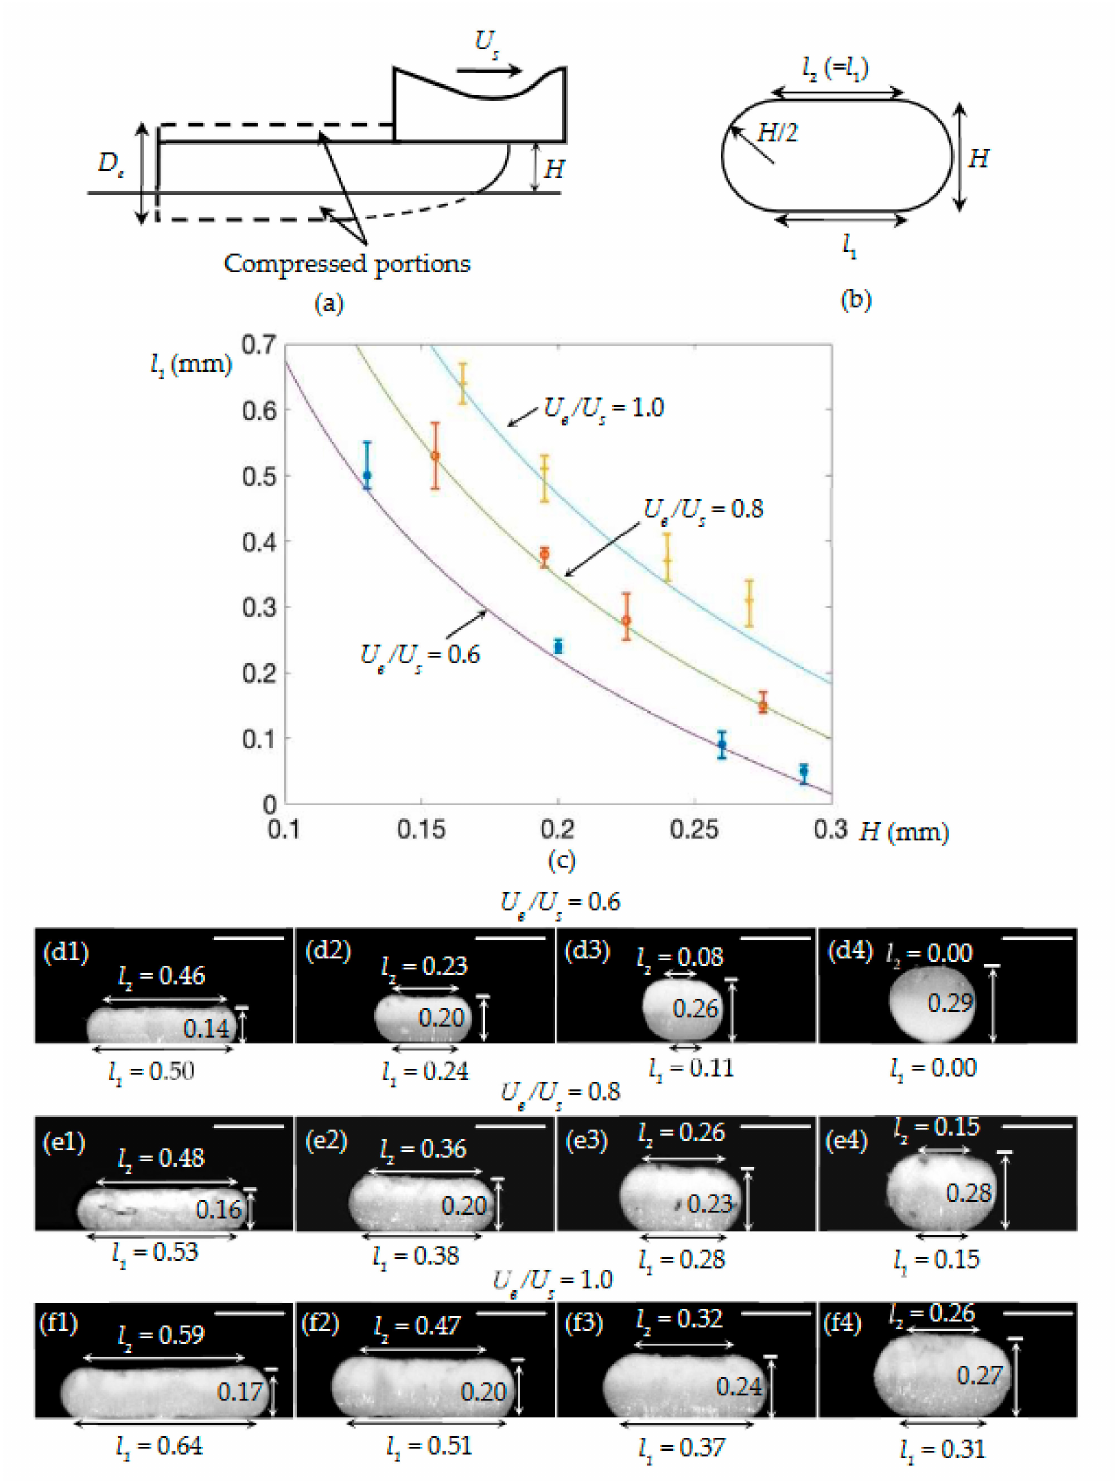
Figure 4. ( a ) Illustration of Case I.2. ( b ) Predicted cross-section of a deposited strand. ( c ) Theoretical and experimental H - l 1 relations. ( d1 – f4 ) Representative cross-sections of the deposited strands, when U e / U s ranged from 0.6 to 1.0 for various nozzle heights. Scale bar: 0.30